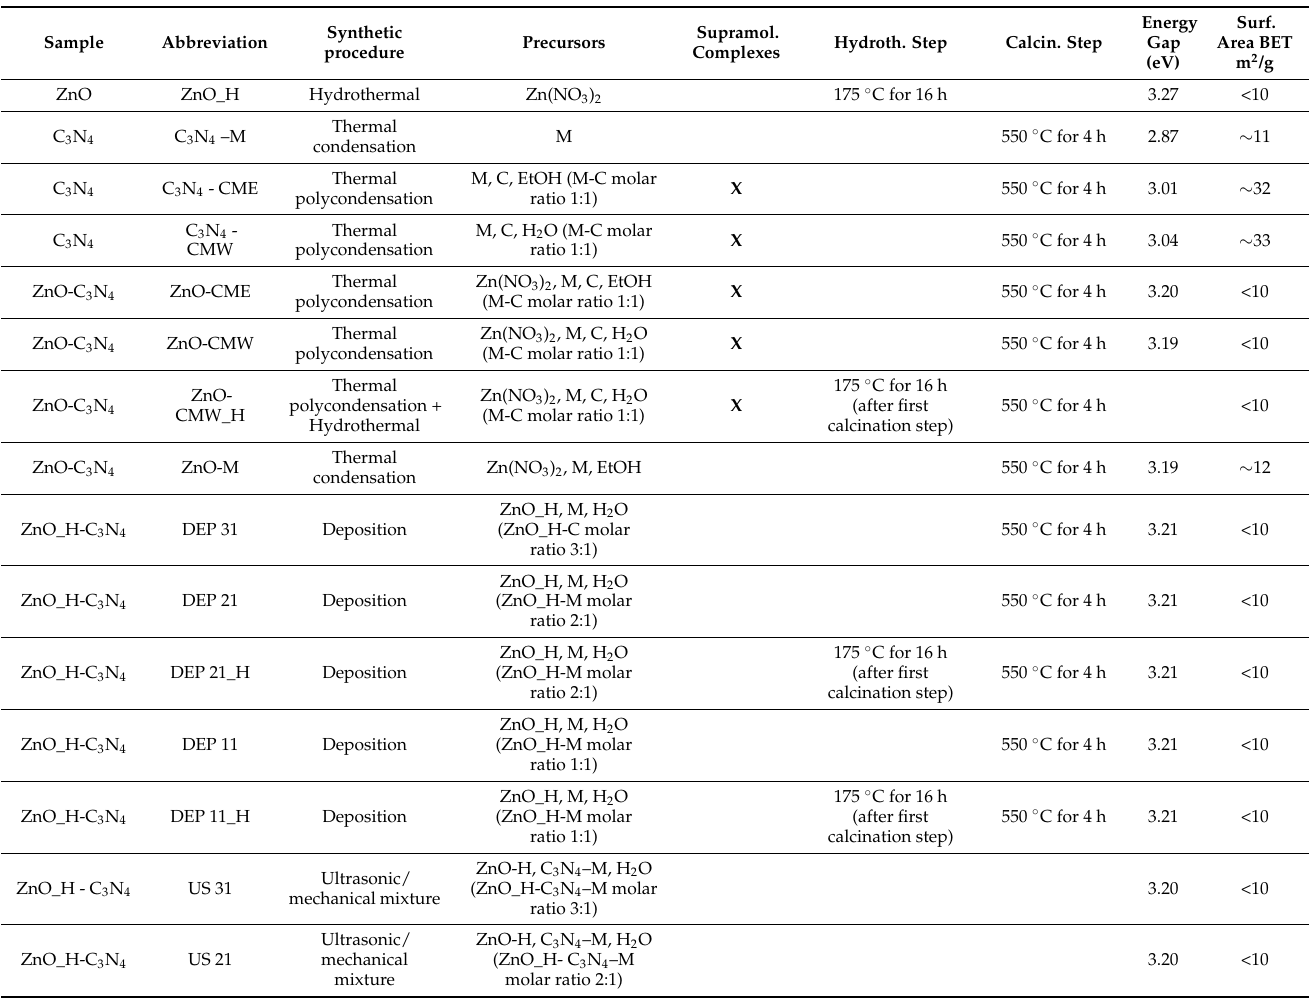
Table 1. Summary of the synthetic routes, precursors and thermal treatments employed for the